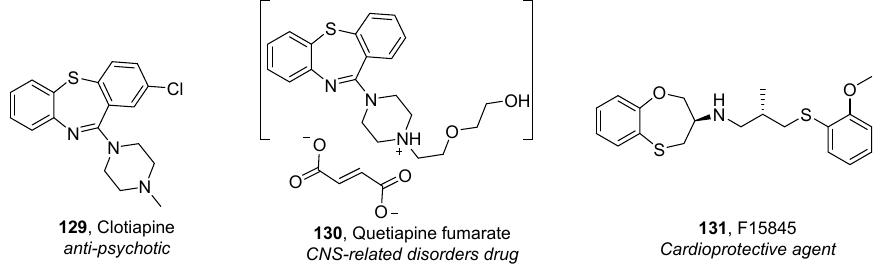
Figure 9. Relevant examples of bioactive dibenzothiazepines.